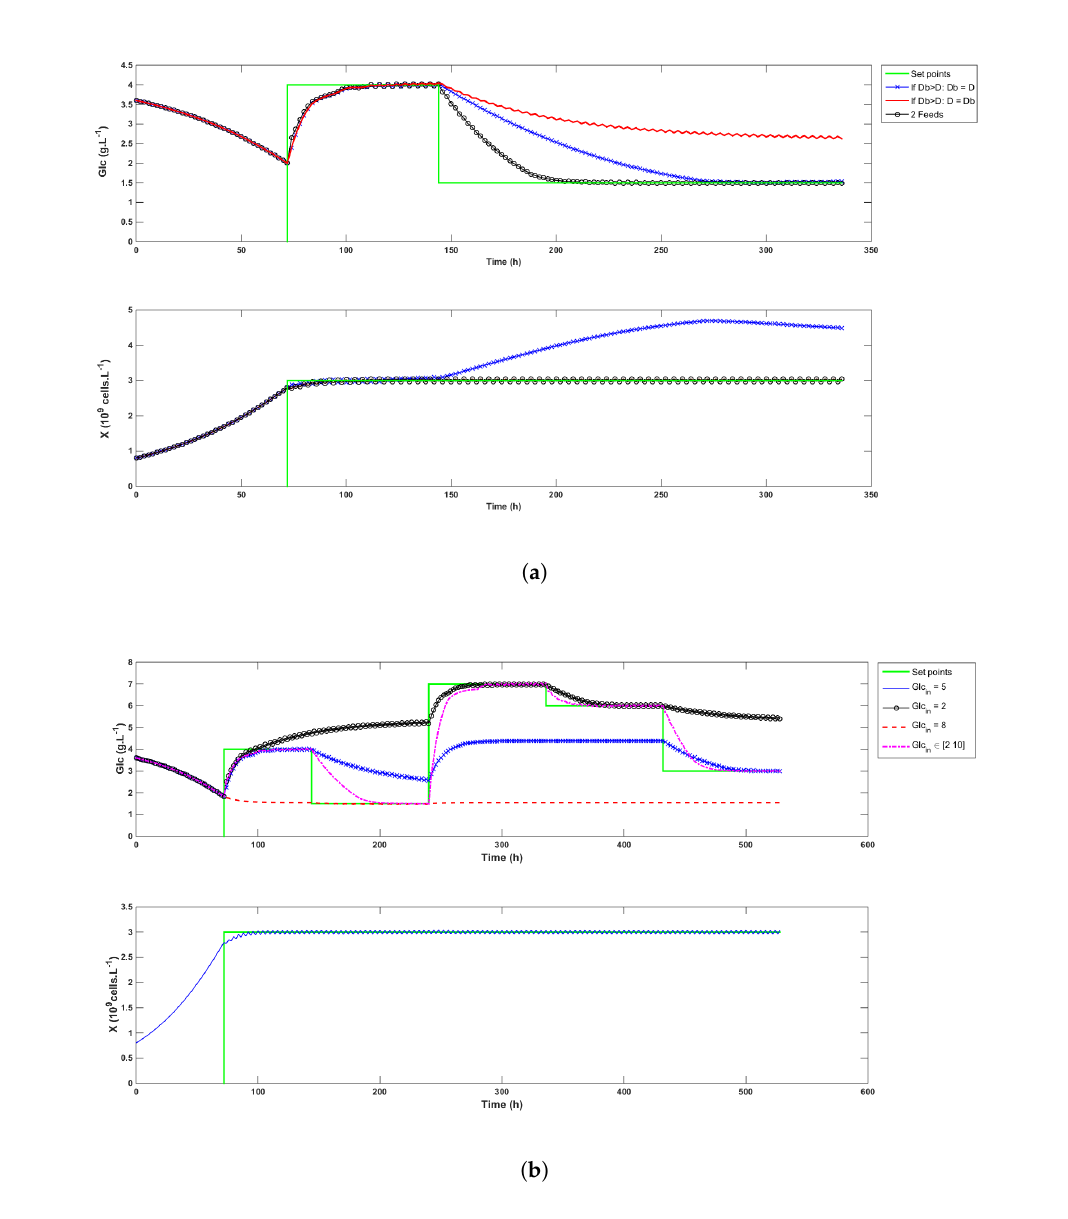
Figure 4. Simulation tests of the control strategy. Graph ( a ) shows that setting D b = D when D b > D deteriorates the biomass control. Graph ( b ) illustrates the flexibility that is gained having two different feed